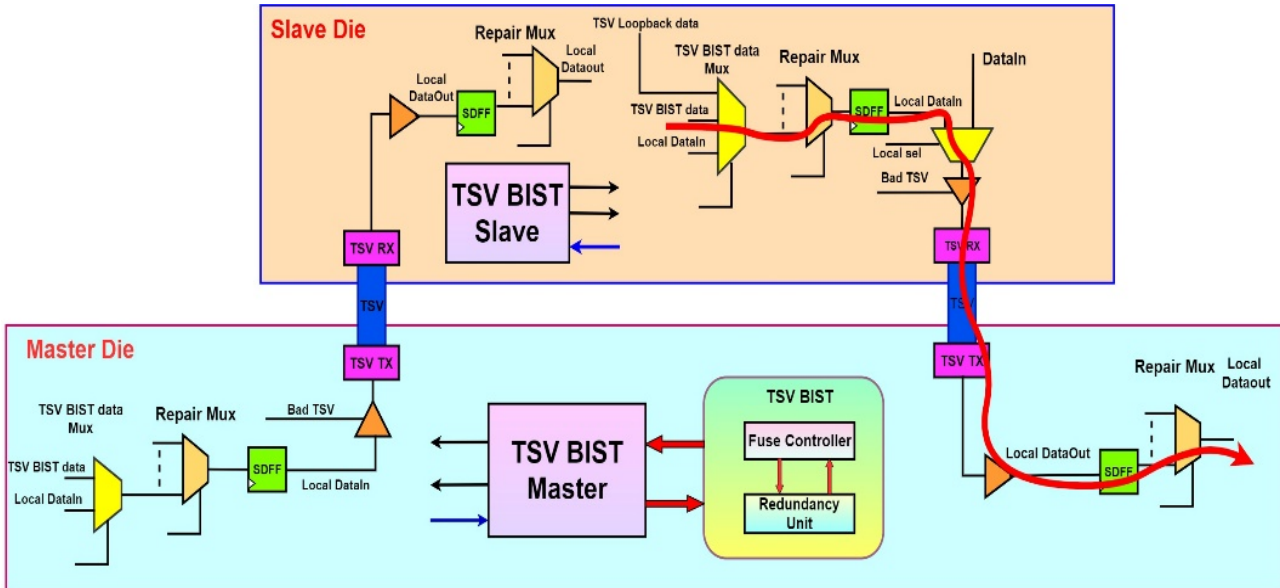
Figure 4. Read Group data path in TSV BIST Repair flow for 3D ICs.